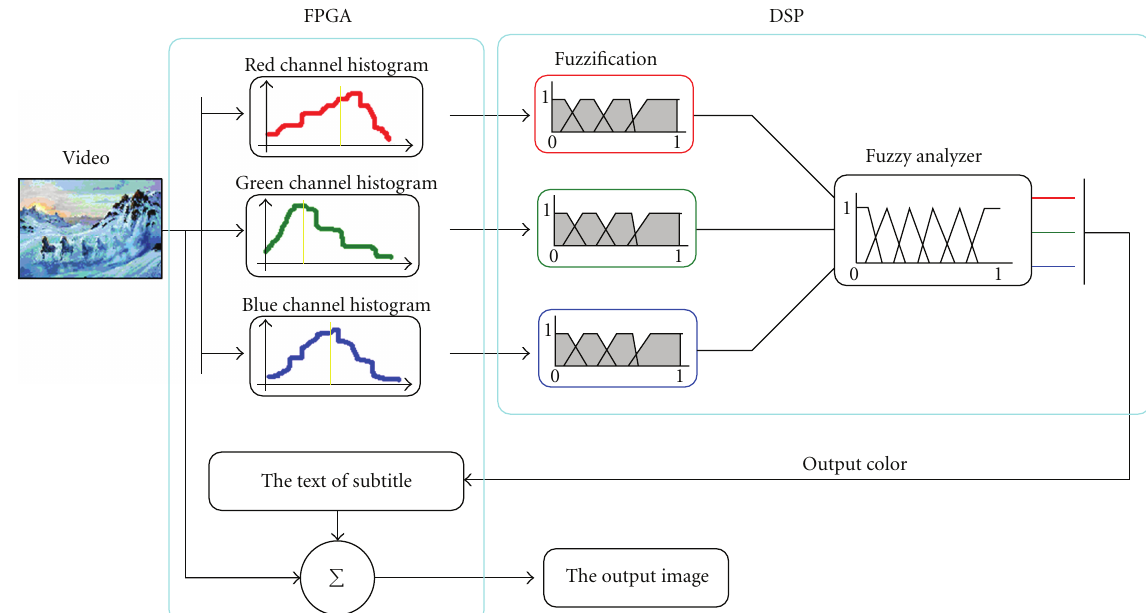
Figure 1: The block diagram of the fuzzy logic-based video subtitle coloring system.